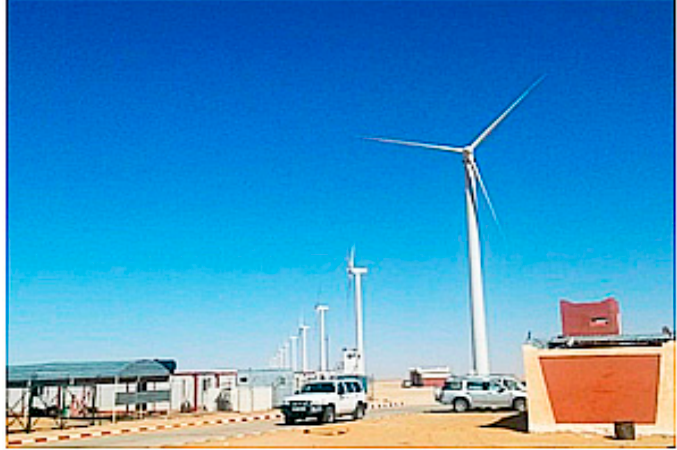
Figure 16. Pilot wind farm of 10.2 MW in Kabertene. Table 17. Technical data of Gamesa G52-850 [102].